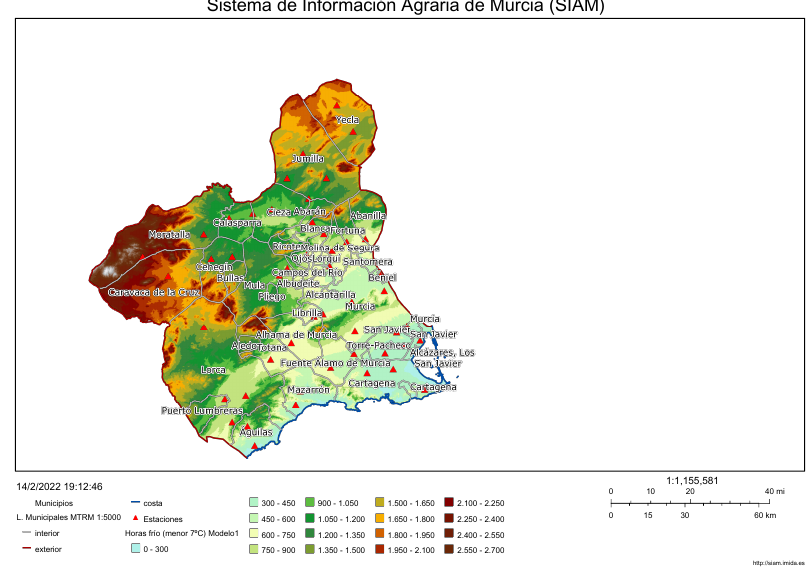
Figure 6. Case example: ground-based data available online (Region of Murcia, Spain) [90].